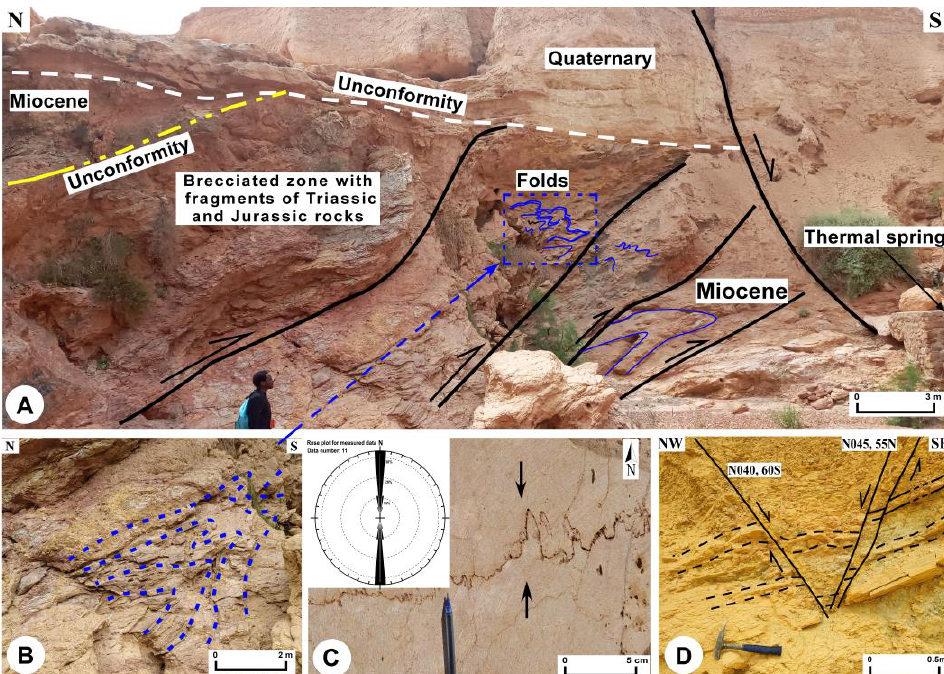
Figure 3. ( A ) Structures associated with the E – W thrust at Wadi El Abd, in the vicinity of the thermal spring of Goutitir; ( B ) folds associated with this overlap; ( C ) stylolites outcropping in limestones associated with the compression phase; ( D ) horst and graben structure. The arrows show the movement of the faults.